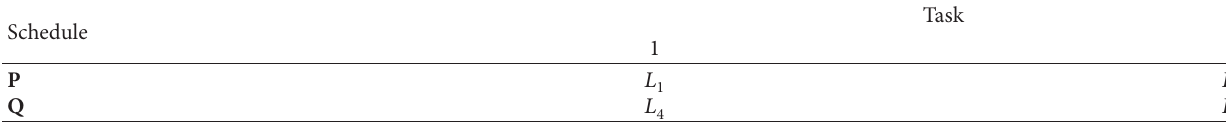
Table 4: The assignment of schedules P and Q .